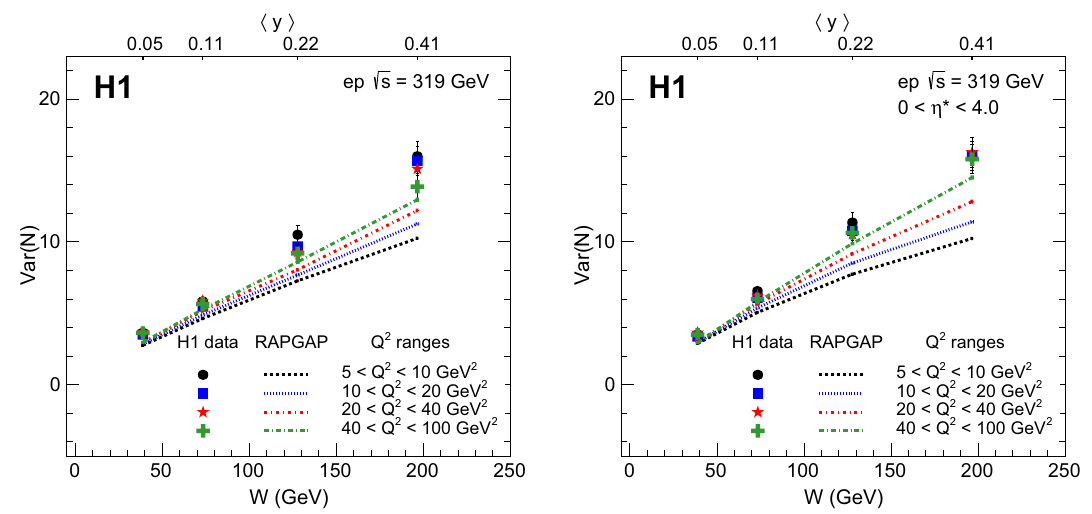
Fig. 9 Second moment (variance) of the multiplicity distributions The corresponding (cid:8) y (cid:9) is indicated by the top axis for each measured √ Var ( N ) as a function of W measured at s = 319GeV ep colli- W . Predictions from the RAPGAP model are shown by dashed lines. sions (left) and with an additional restriction to the current hemisphere The total uncertainty is represented by the error bar 0 < η ∗ < 4(right).FurtherphasespacerestrictionsaregiveninTable1.